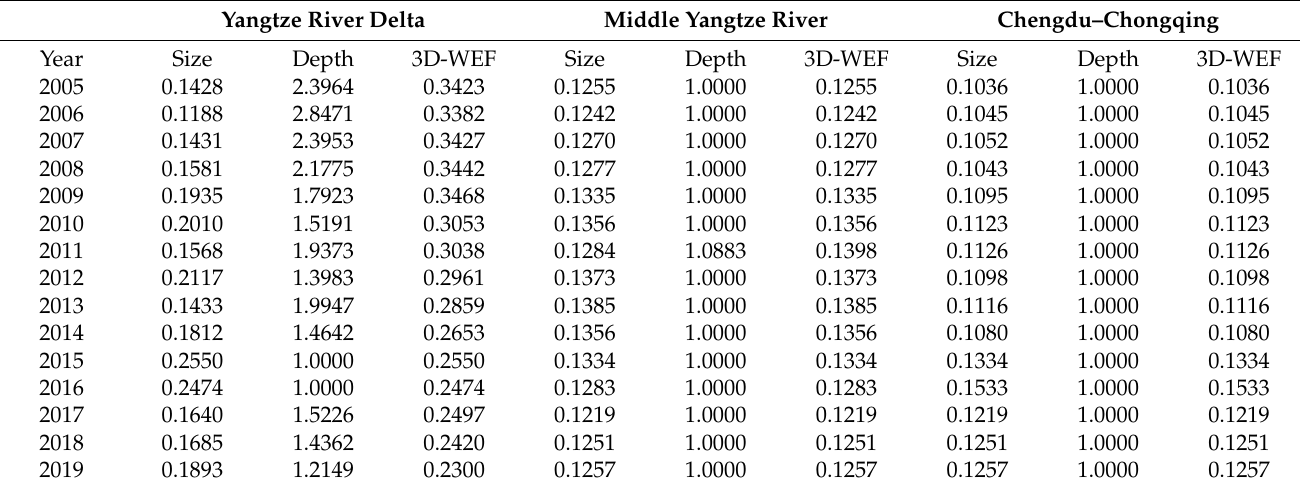
Table 3. Size and depth of WEF and three-dimensional WEF.